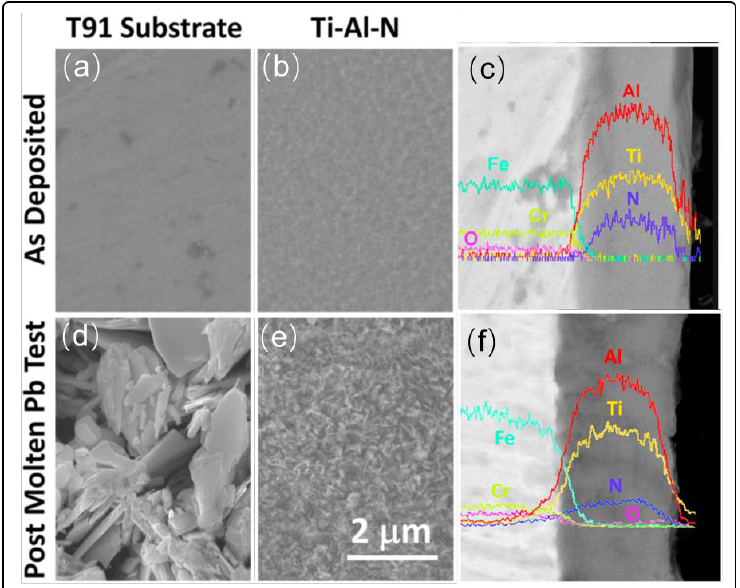
Figure 9. Corrosion performance of TiAlN coating in liquid Pb ( a ) SEM photo of T91 pre-corrosion surface ( d ) SEM photo of T91 post-corrosion surface ( b , e ) SEM photo of TiAlN coating before corrosion and corrosion dipstick ( c , f ) Cross-sectional elemental distribution curve of TiAlN coating before and after corrosion [81]. Figure 9 is reproduced with permission from [81]. Copyright 2019 Elsevier.